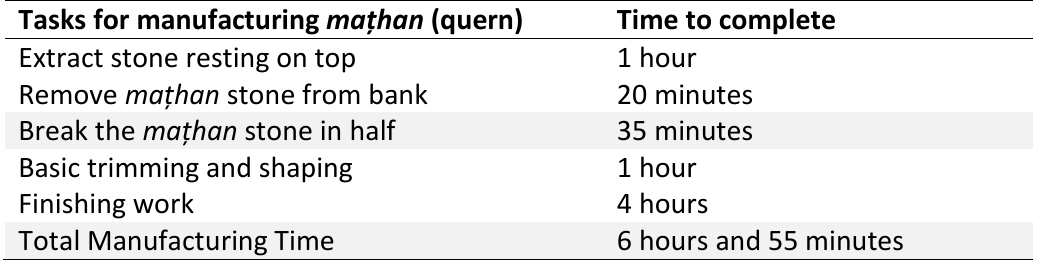
Table 3. Time to complete manufacturing (using metal